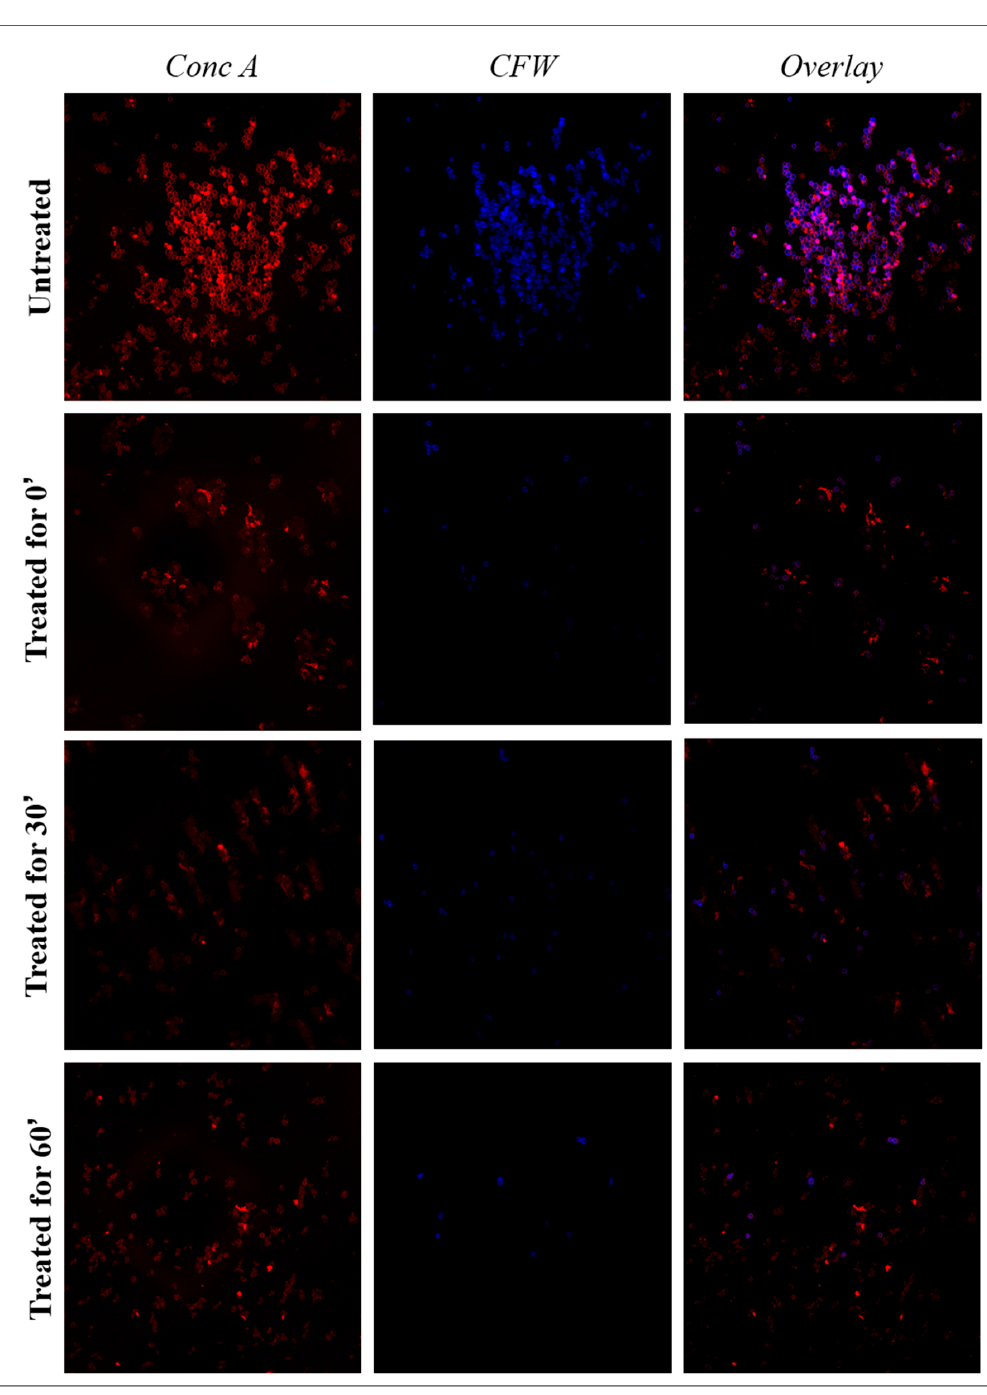
Figure 4. Confocal laser scanning microscopy of cell wall components of C. albicans 1/18 clinical isolate treated with the distilled extract of bergamot for 60 ′ . Double-staining of chitin and mannan fluorescently labeled with Calcofluor white (CFW) and Concanavalin A (Conc A), respectively, was performed. “Untreated”: growth control of C. albicans 1/18 ; “treated”: C. albicans 1/18 treated with the distilled extract of bergamot (MBC). The reduction in fluorescence intensity shows a decrease in the relative cell wall components.